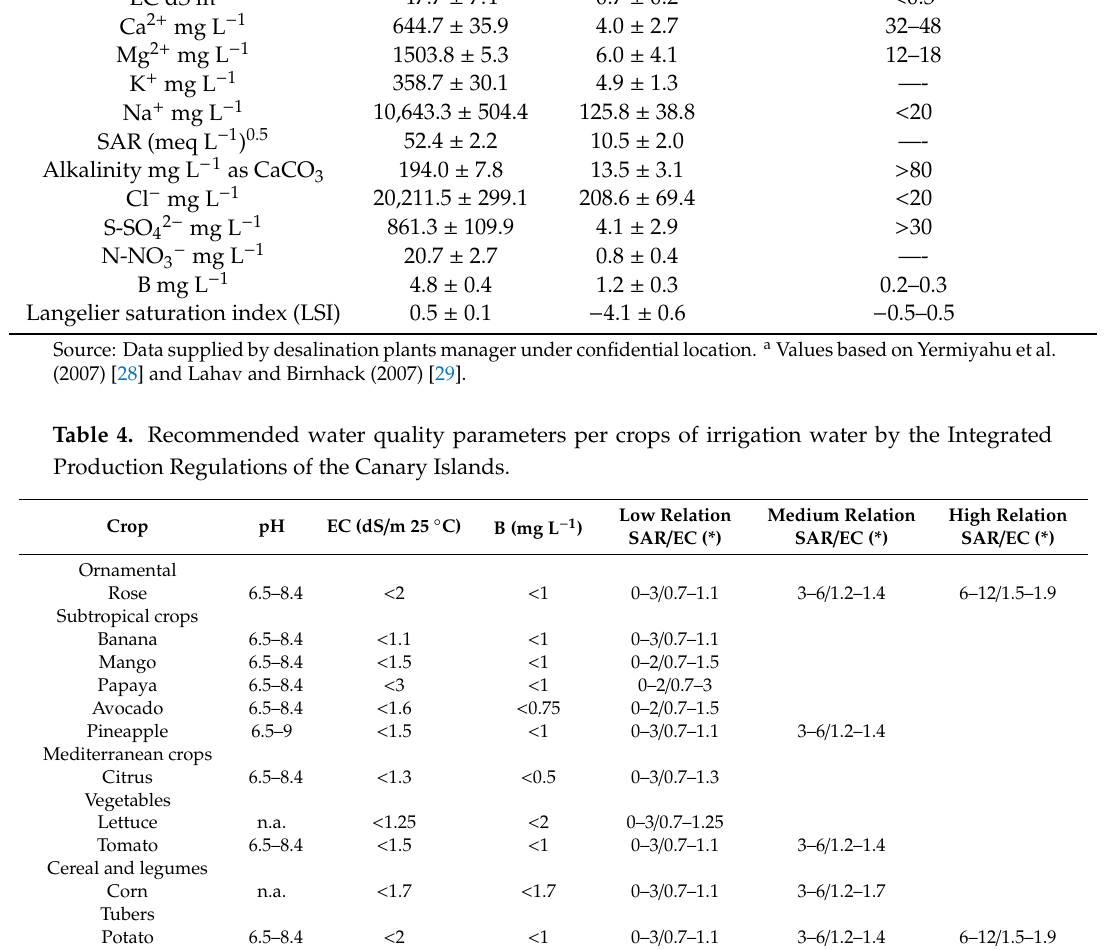
Source: Canary Islands Regional Integrated Production Regulations of the Canary Islands related to potato, banana, tomato, avocado, mango, papaya and pineapple. (*) SAR and EC values for each relation without irrigation